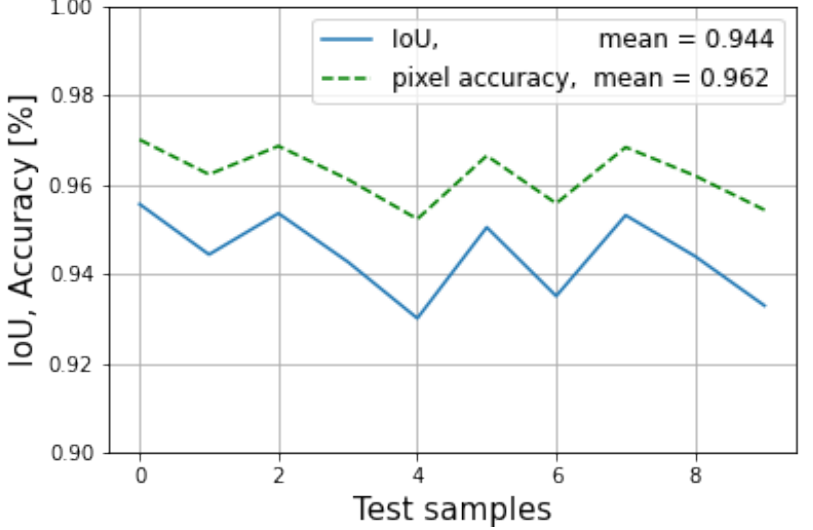
Figure 24. The IoU and pixel accuracy are shown for the testing